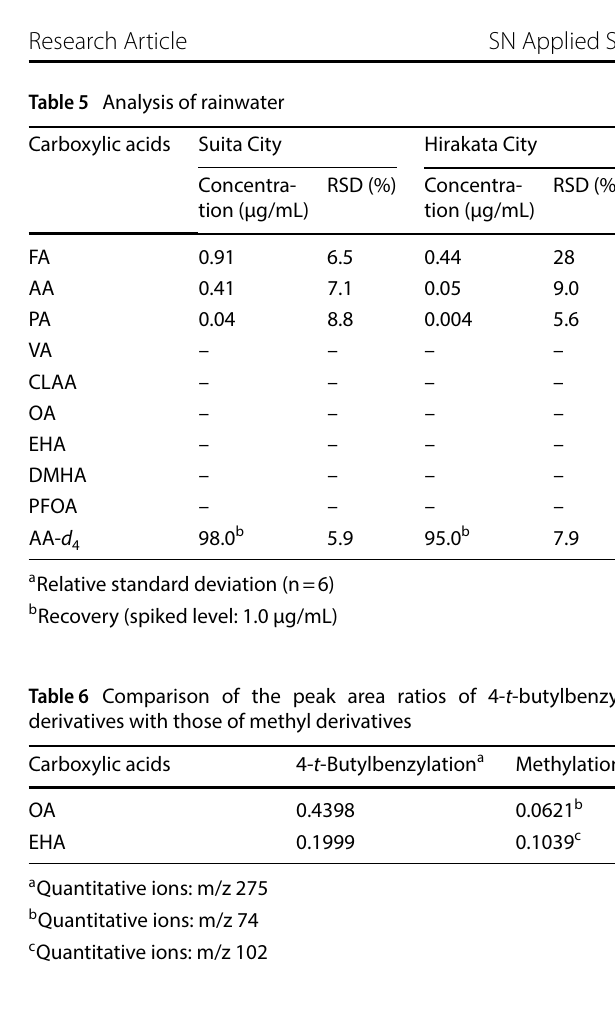
Table 5 Analysis of rainwater